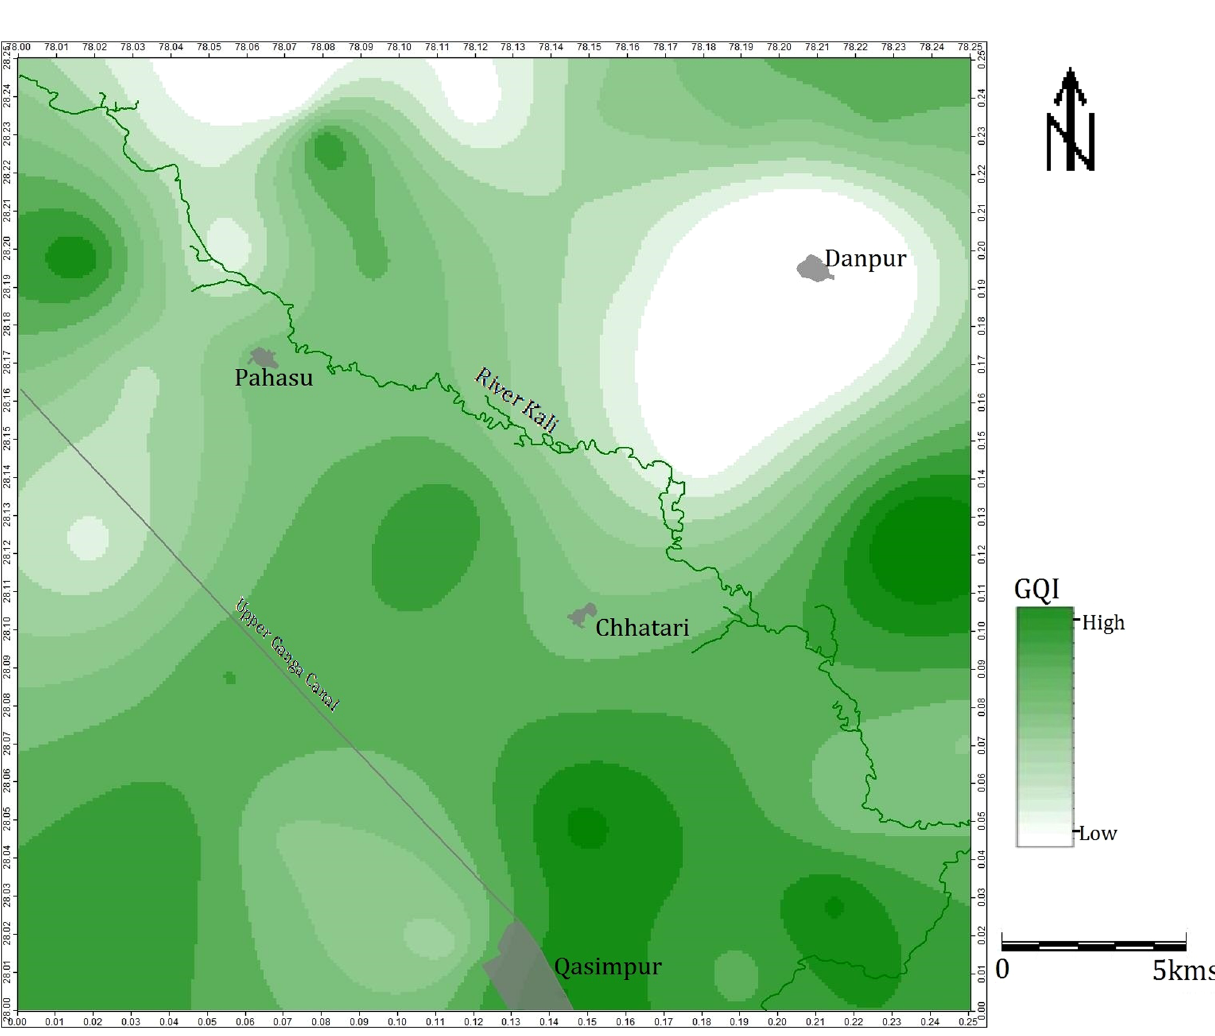
Fig. 4 Groundwater quality index map for pre-monsoon